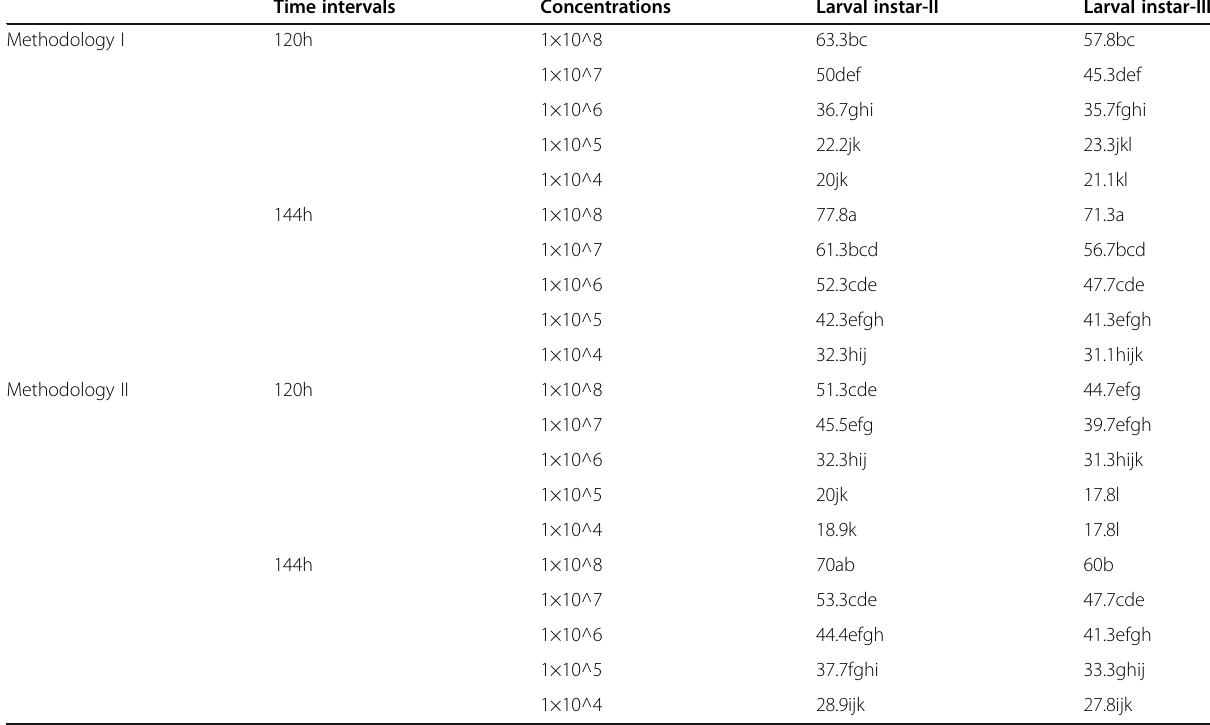
Mortality (±S.E) assigned with similar letters within each column is statistically similar ( α